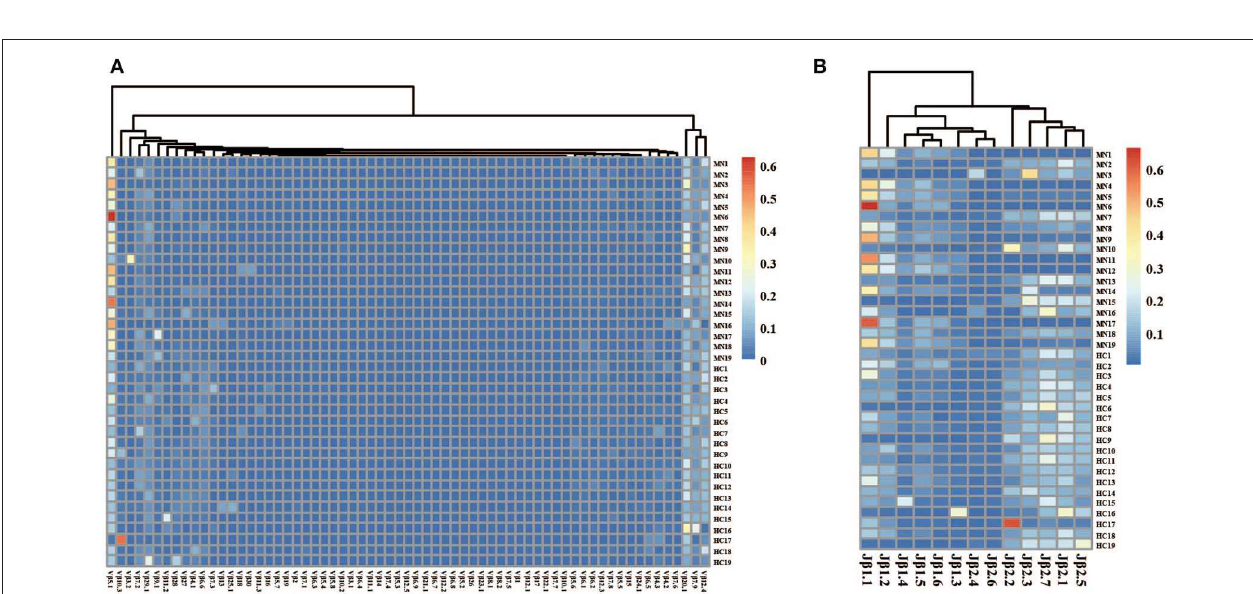
FIGURE 2 | The heat maps of V β (A) and J β (B) gene usage frequencies in peripheral blood TCR repertoire of each sample from the MN patients and healthy controls.